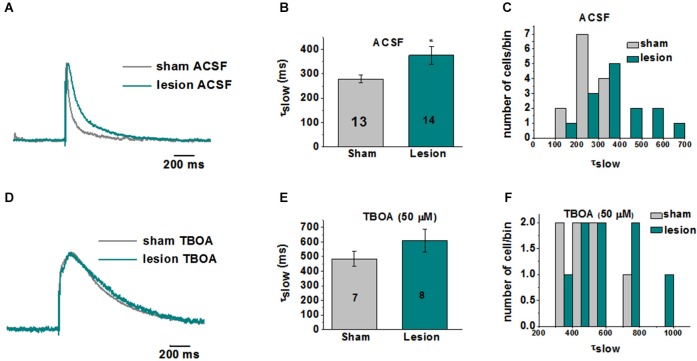
Kinetics of NMDA receptor-mediated EPSCs are altered in layer II/III pyramidal neurons in lesioned cortex relative to sham-operated littermates. (A) Representative traces (each recording is the average of 3 traces) indicate slowed NMDA receptor-mediated EPSC decay kinetics in lesioned animals. (B) Mean data from 13 sham and 14 lesioned neurons demonstrates a significant increase in τslow in neurons from the lesioned cortex relative to sham littermate controls. (C) Histograms of τslow indicate a greater number of cells in bins with larger τ values for the lesion group. (D) Representative traces showing no difference the NMDA response between the sham and lesioned neurons in the presence of TBOA (50 µM). (E) Mean data from 7 sham and 8 lesioned neurons indicate TBOA has a similar effect on the τslow NMDA receptor kinetics. (F) Histograms of τslow in TBOA indicate no difference between sham and lesion in τ bins.